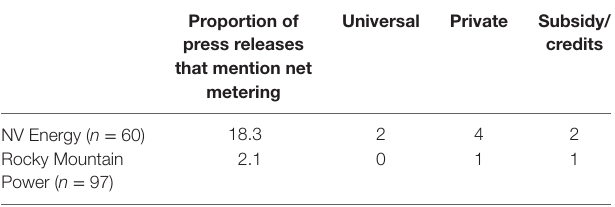
taBle 2 | Proportion of press releases by each utility company that mention net metering and frequency of key terms in